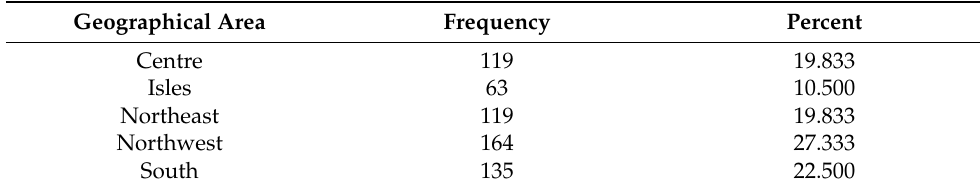
Table 1. Participants’ geographical Area. Geographical Area Frequency Percent